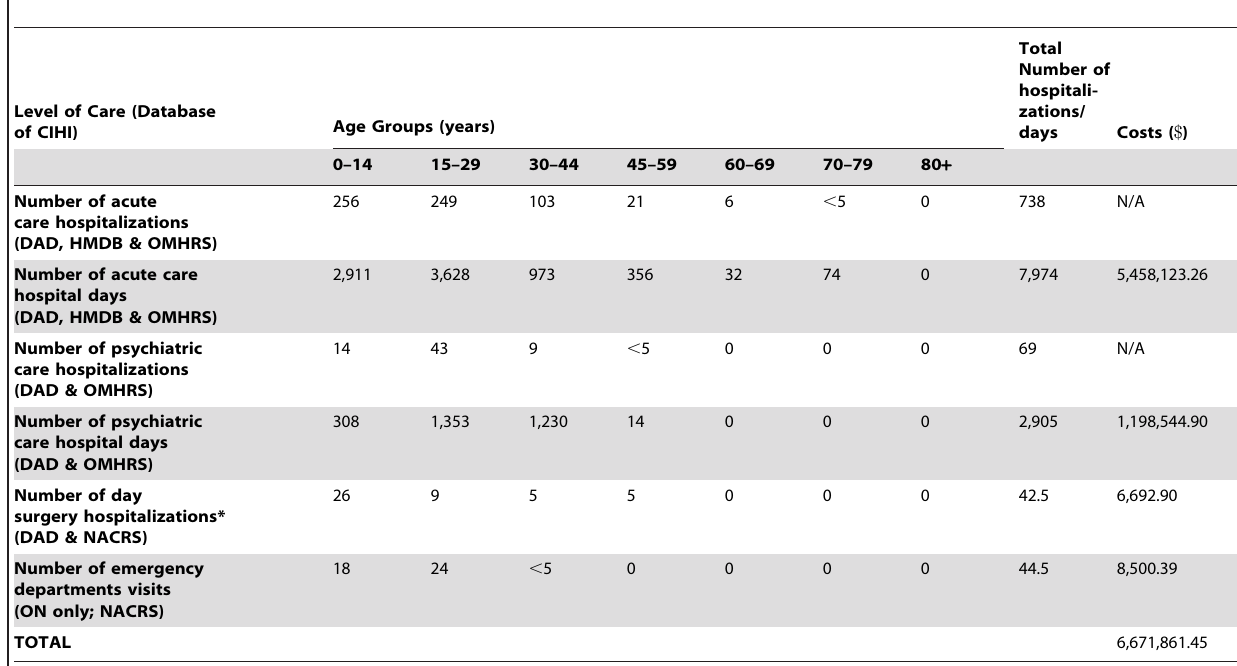
Table 2. Number of recorded hospitalizations and visits and hospital days, associated with a diagnosis of FAS and the associated costs in Canada for